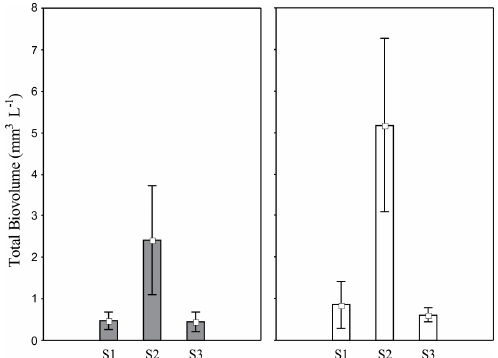
Figure 4. Mean values and standard error (bars) of the total phytoplankton biovolume in the lakes related to the dammed river (S1 - Paraná River) and non-dammed ones (S2 - Baia River and S3 -Ivinhema River), in the dry (gray) and rainy (white) periods.